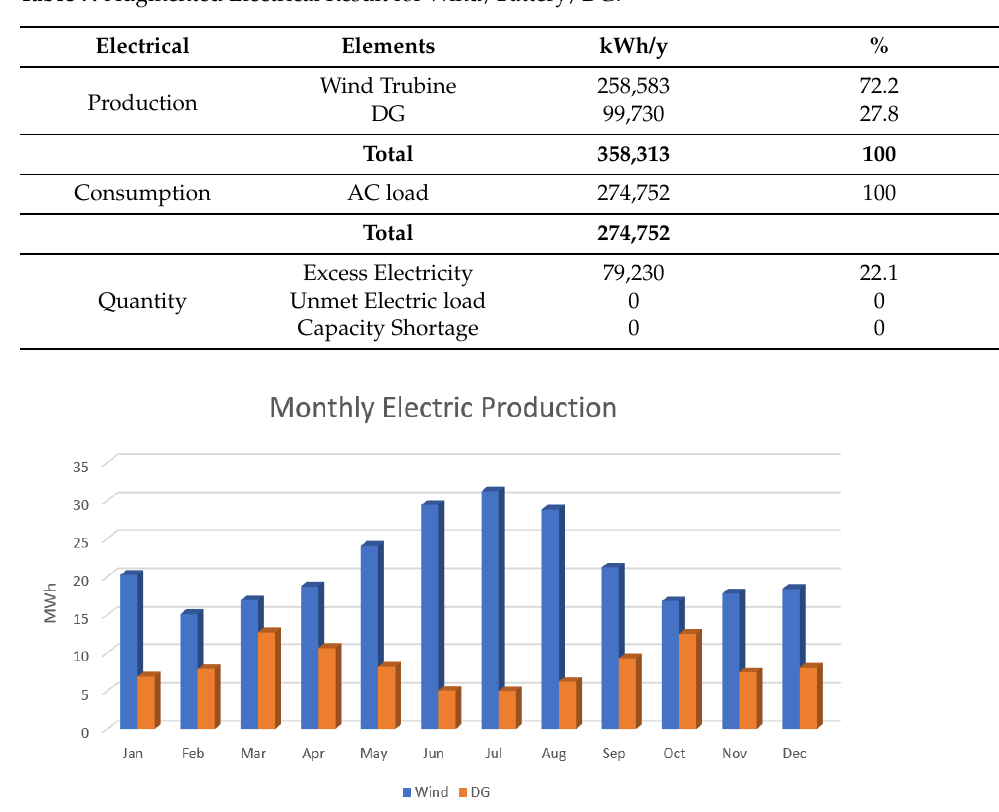
Figure 10. Wind/Battery/DG-based electricity production throughout the